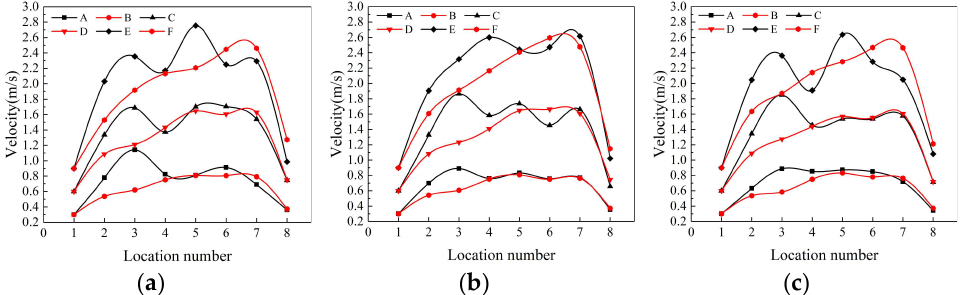
Figure 6. Velocity at vital locations of two Tesla pipelines under different slopes (( a ). slope = 0%, ( b ). slope = 5%, ( c ). slope = 10%. Black lines A, C, and E are for GMF Tesla valve, and the initial speeds are 0.3 m/s, 0.6 m/s, and 0.9 m/s, respectively; red lines B, D, and F are for T45-R Tesla valve, with initial speeds of 0.3 m/s, 0.6 m/s, and 0.9 m/s, respectively).